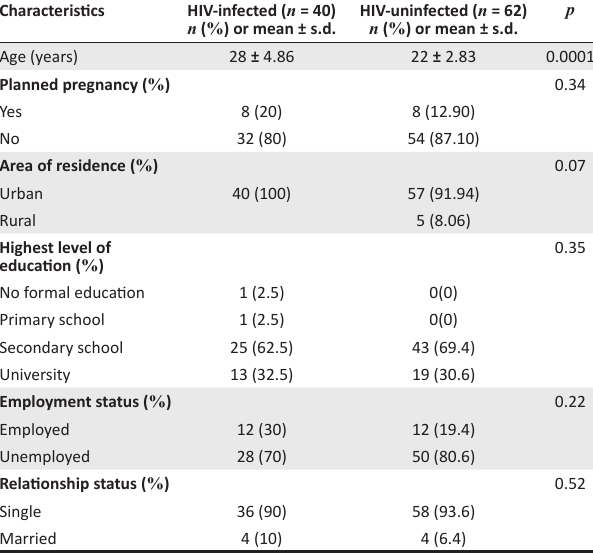
TABLE 1: Background characteristics of study population. Characteristics